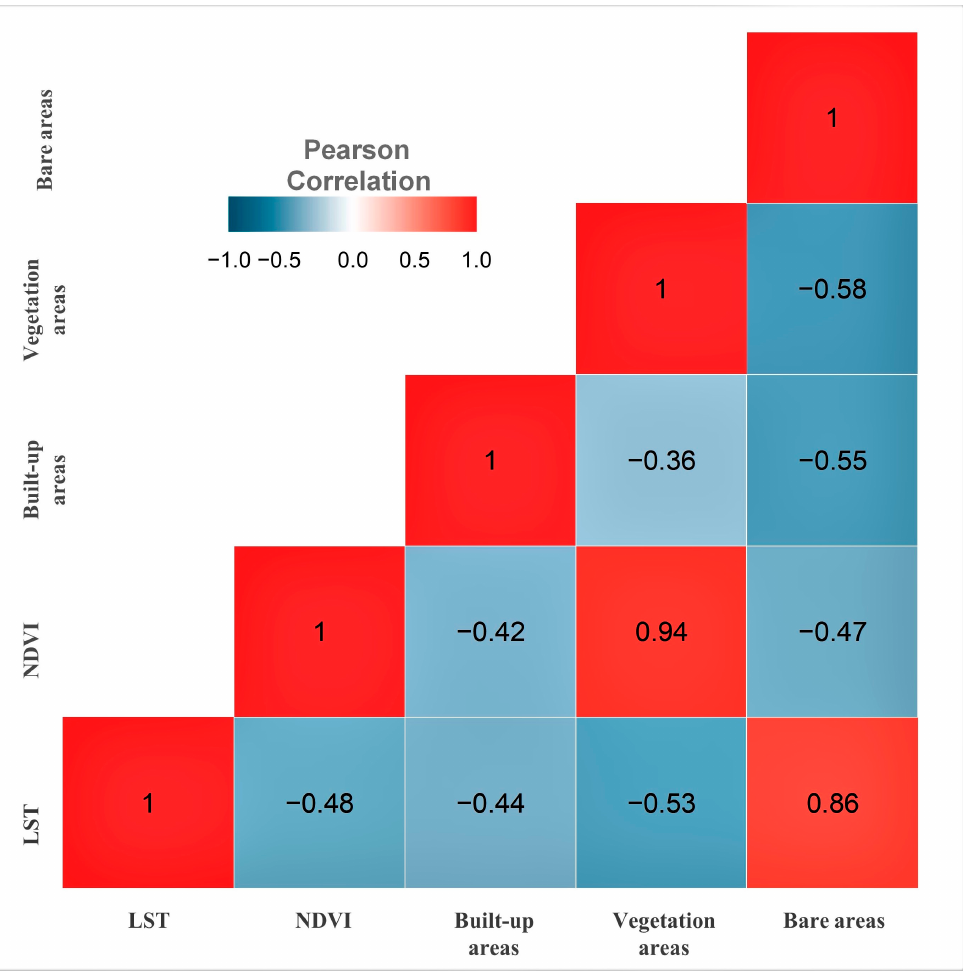
Figure 6. Relationship between LST, NDVI, bare areas, vegetated areas and built-up areas.